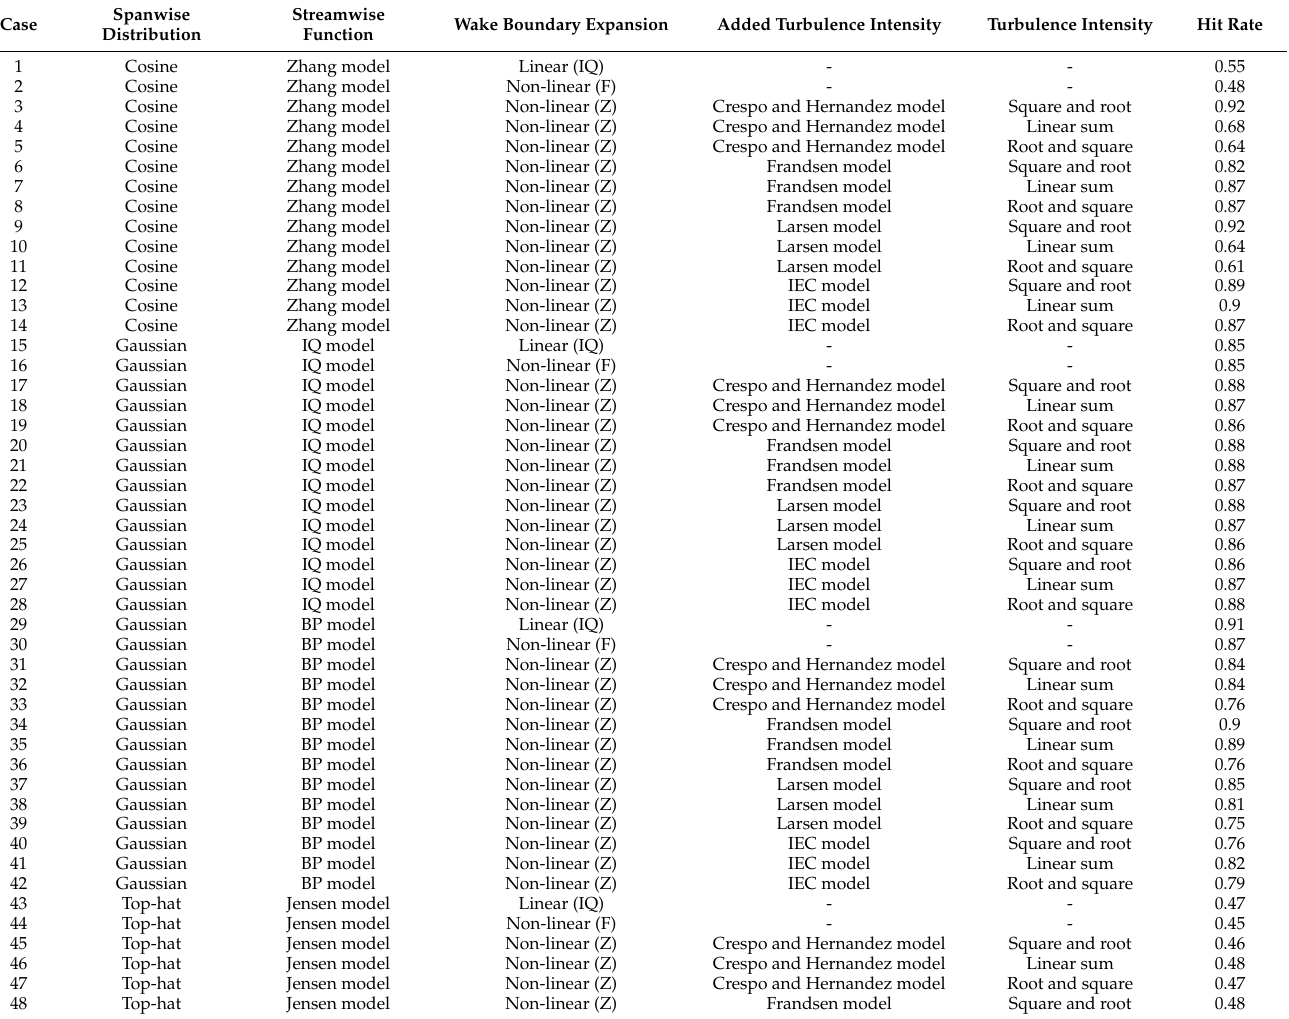
Table A1. Descriptions of the combined wake